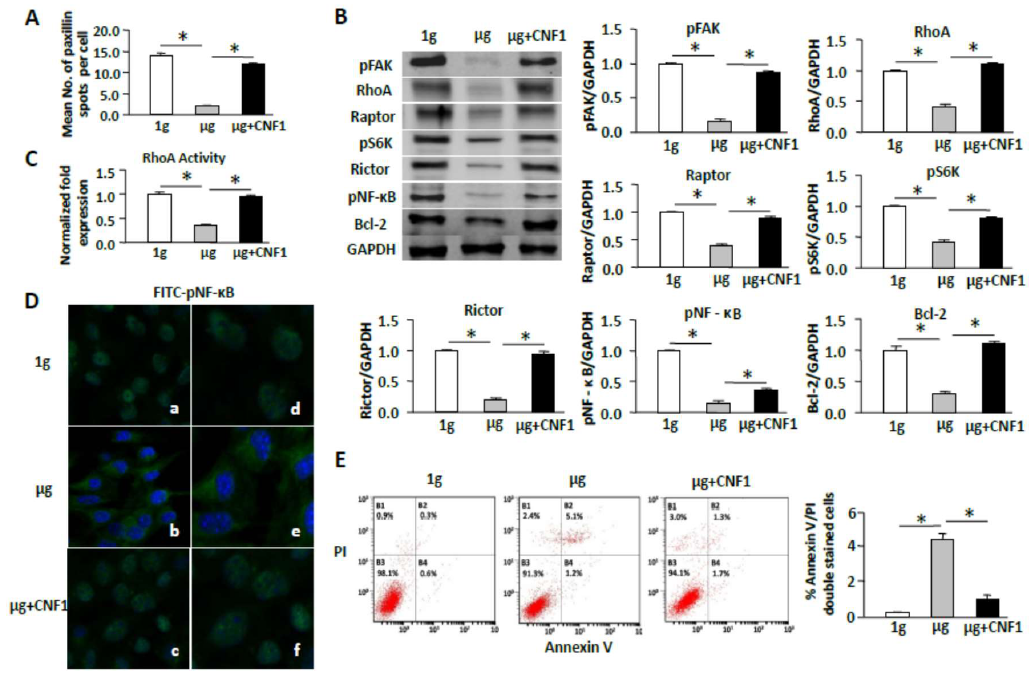
Figure 7. CNF1 restores focal adhesions and NEPCs and activates FAK/RhoA, mTORC1/NF-κB, and ERK1/2 pathways leading to apoptosis reduction in cells under SMG. ( A ) BL6-10 cells were